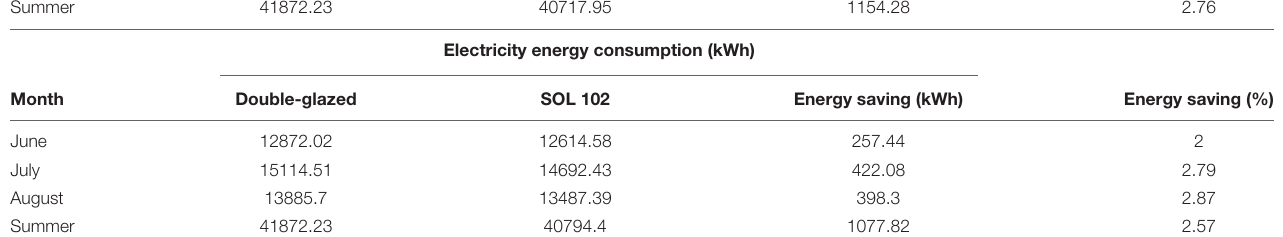
Figure 14 . For one floor of the ACK building in June 2019, detailed simulations on CO 2 footprint reduction and energy